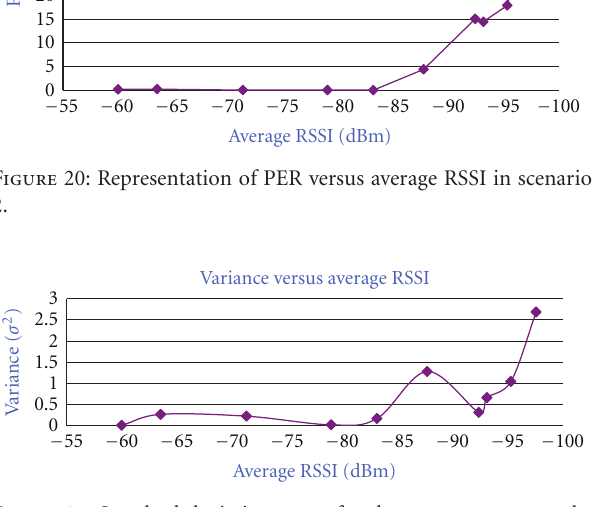
Figure 21: Standard deviation curve for the measurement results previously